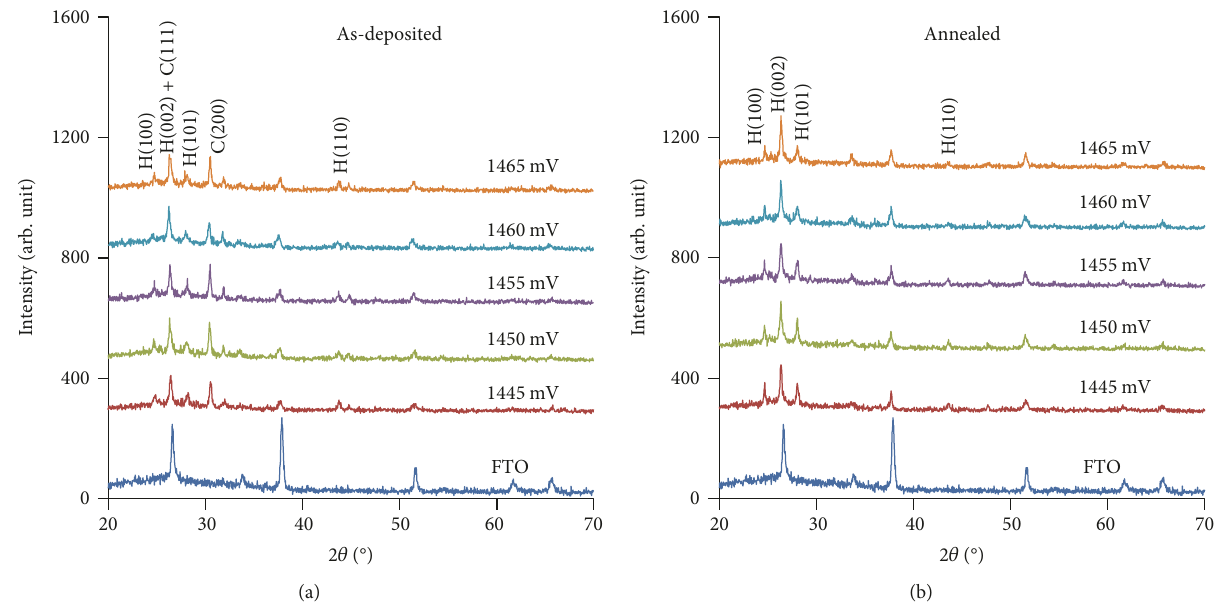
Figure 2: XRD patterns of (a) as-deposited and (b) annealed CdS layers deposited for 45 minutes at di ff erent cathodic growth (100) peaks occur at 2 θ values in the range 24.7 – 24.9 ° , the (002) peaks at 2 θ values in the range 26.3 – 26.5 ° , the (101) peaks at 2 θ values in the range 27.9 – 28.2 ° , and the (110) peaks at 2 θ values in the range 43.6 – 43.7 ° . Similarly, the cubic (111) peaks occur at 2 θ values in the range 26.3 – 26.4 ° and the (200) peaks occur at 2 θ in the range 30.4 – 30.5 ° .